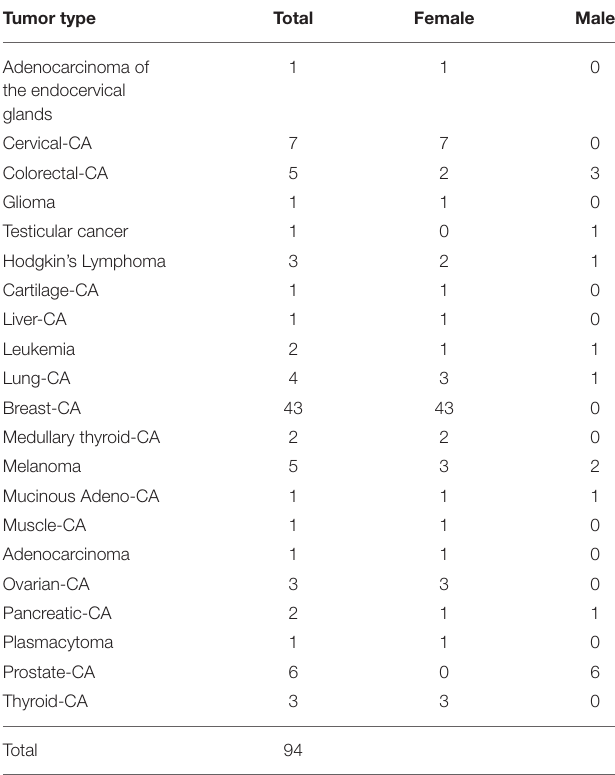
TABLE 1 | Numbers of tumor types among the study